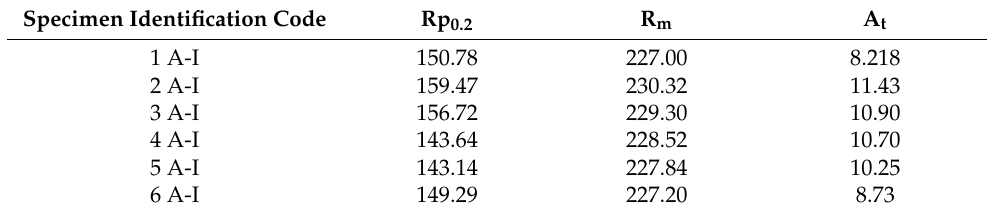
Table 5. Tensile test results.